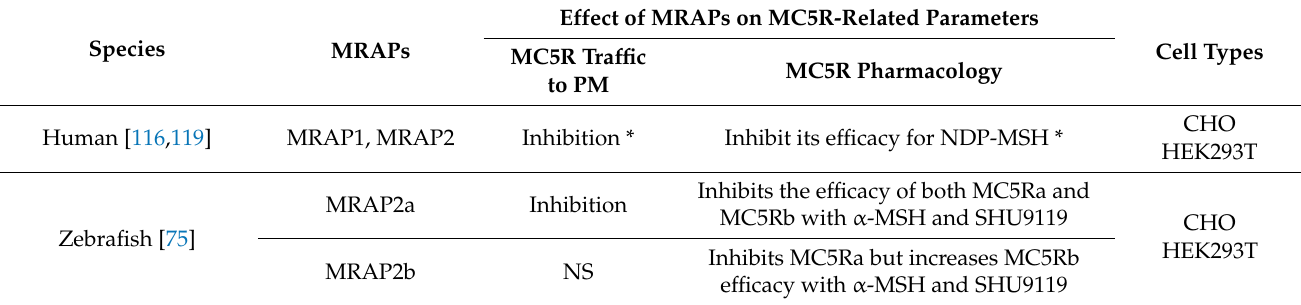
Table 2. The effect of MRAPs on MC5R in various